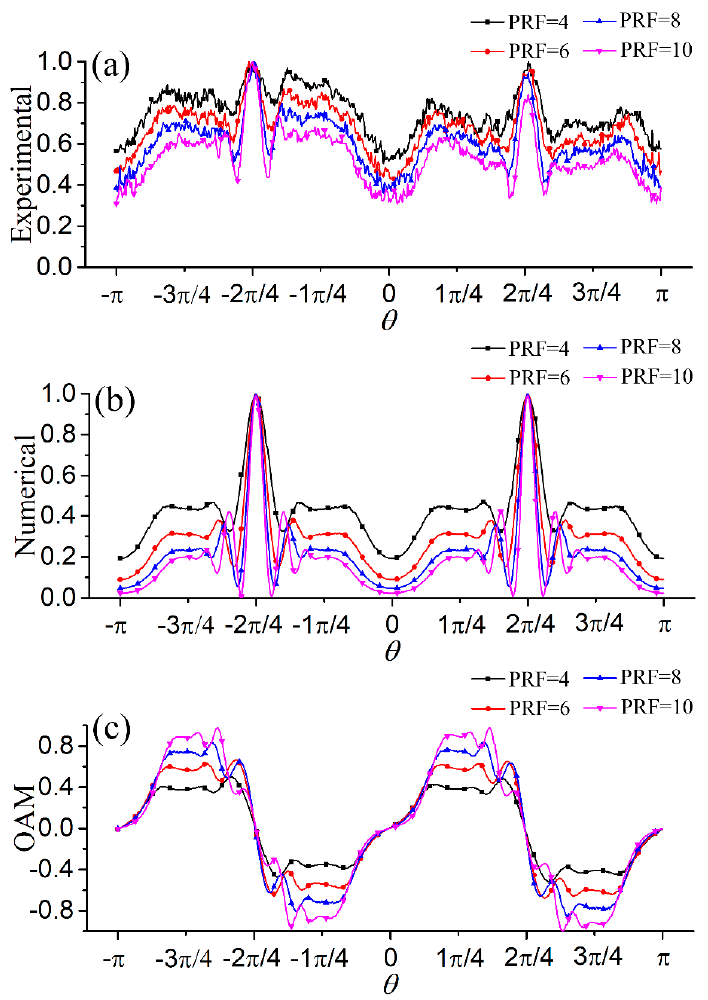
Figure 5. ( a – c ) are the center profiles of the CSOV’s experimental intensity, numerical simulation intensity and OAM rings of Figure 4, respectively. For instance, the positions of the date ring and the three points 0, − π and π are shown in Figure 4a1.